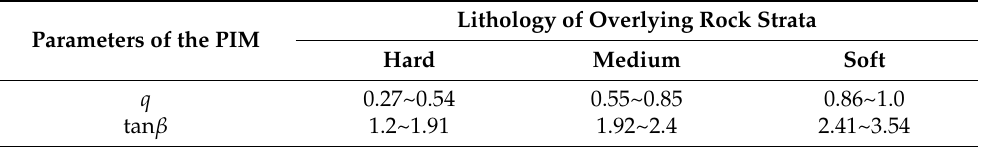
Table 1. The common ranges of the subsidence factor ( q ) and tangent of major influence angle (tan β ) for the hard, medium, and soft overlying rock